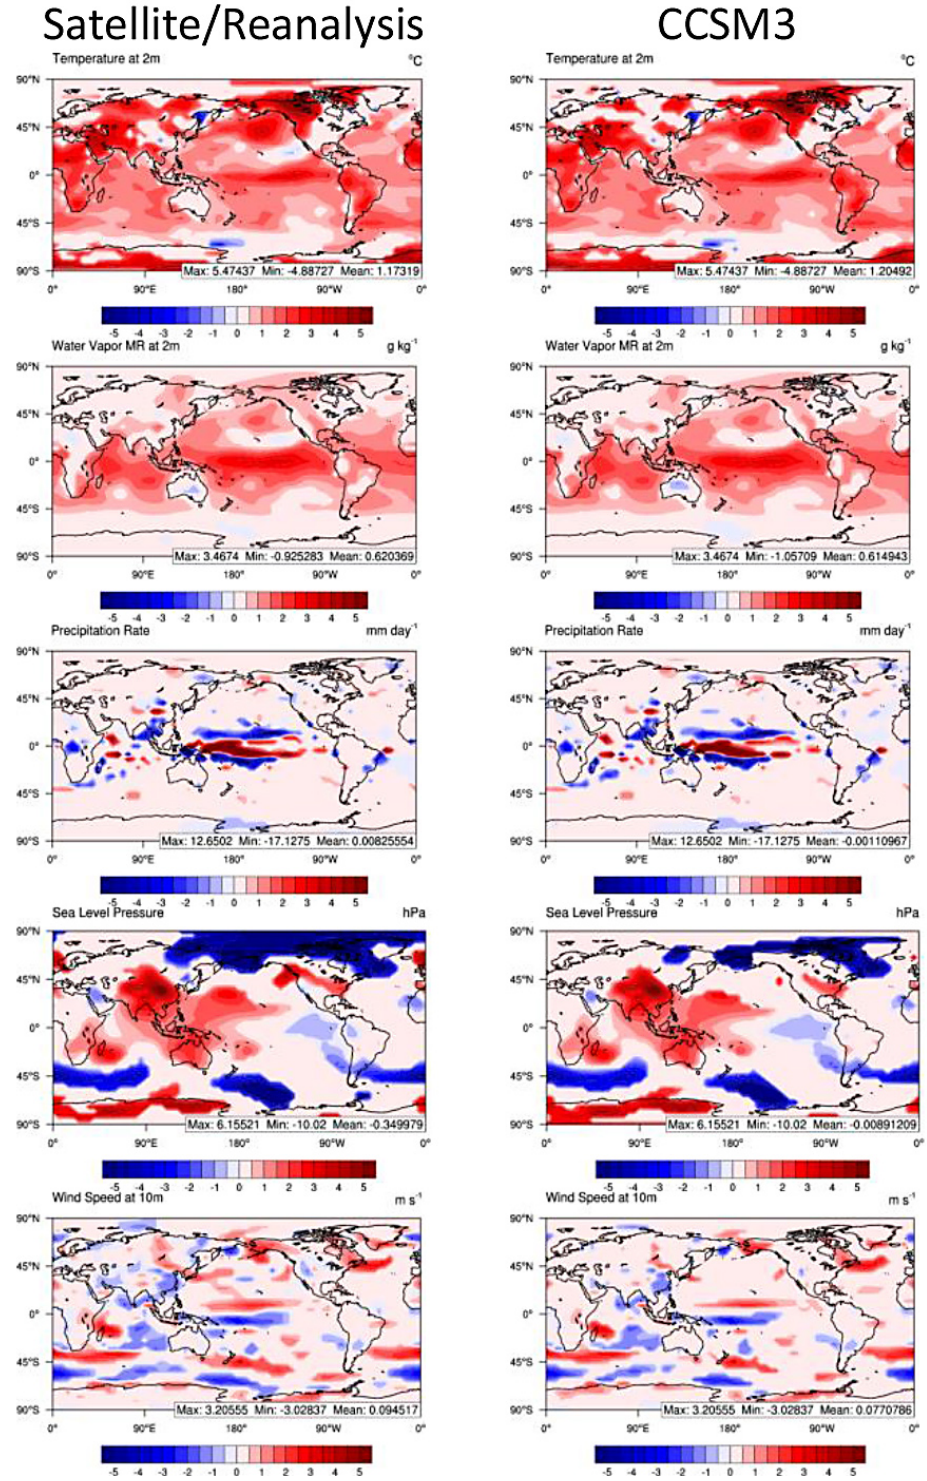
Figure 3a. The statistically significant differences in T2, Q2, SLP, WSP10, WSP5500, PR, GSW, OLR, and GLW between MAM 2050 and 2001 that are greater than the variability in the current climate from reanalysis or satellite data (left) and greater than the variability in the current and future climate from CCSM3 (right). The GLW plot in the bottom row of the CCSM3 column was not generated since the CCSM3 GLW data were not readily